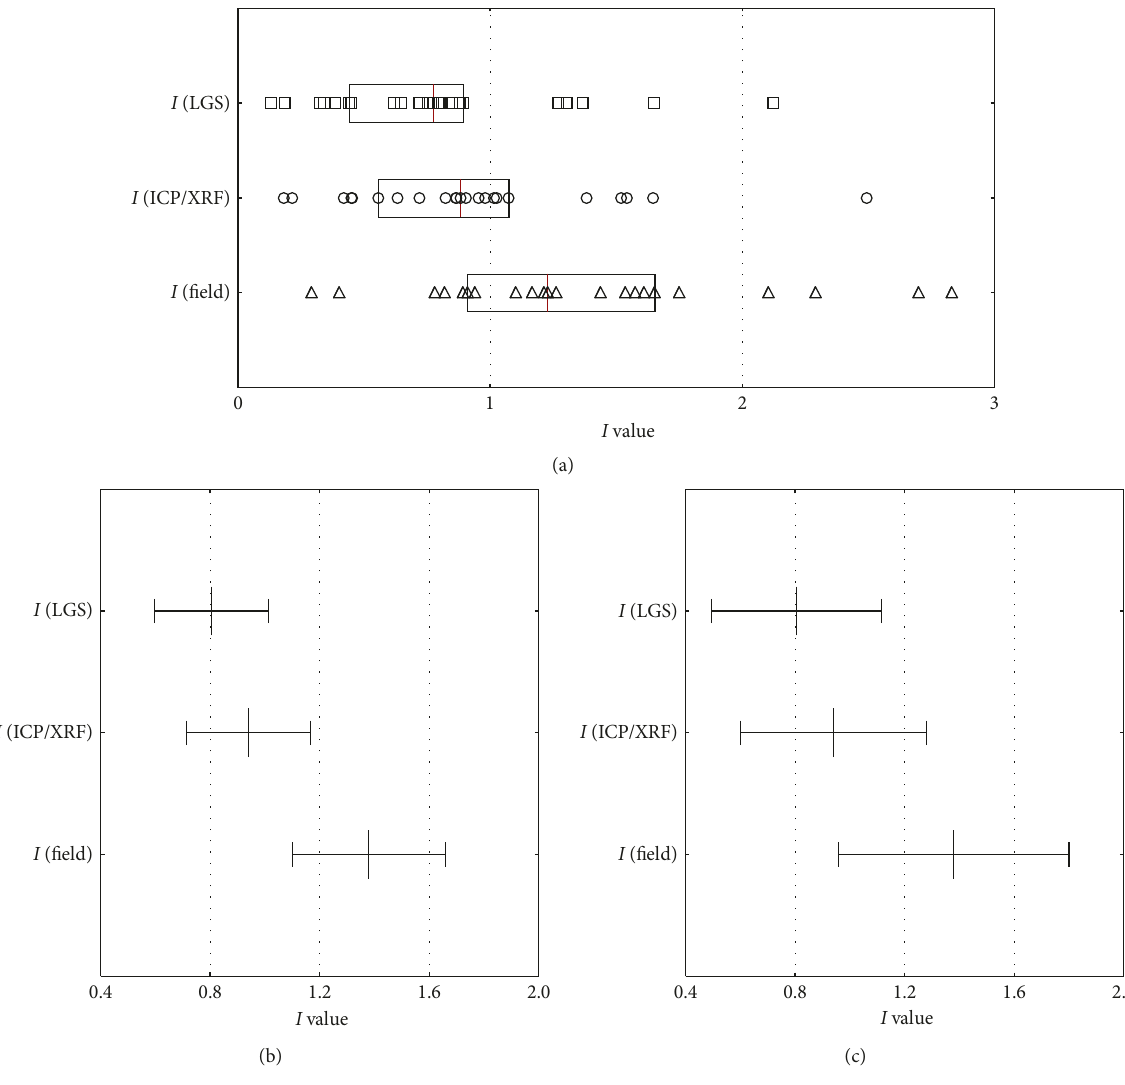
Figure 5: Plots for comparison of the activity concentration index values ( I ) calculated from the laboratory analyses (ICP, XRF, and LGS: laboratory gamma spectrometry) and field estimations: (a) boxplot (quartiles) and raw data plot; (b) mean and standard error plot for 95% confidence; (c) mean and standard error plot for 99.5% confidence. Table 3: Results ( p values) of statistical tests for paired comparisons of estimations of the activity concentration index ( I ) values. N Sign test p